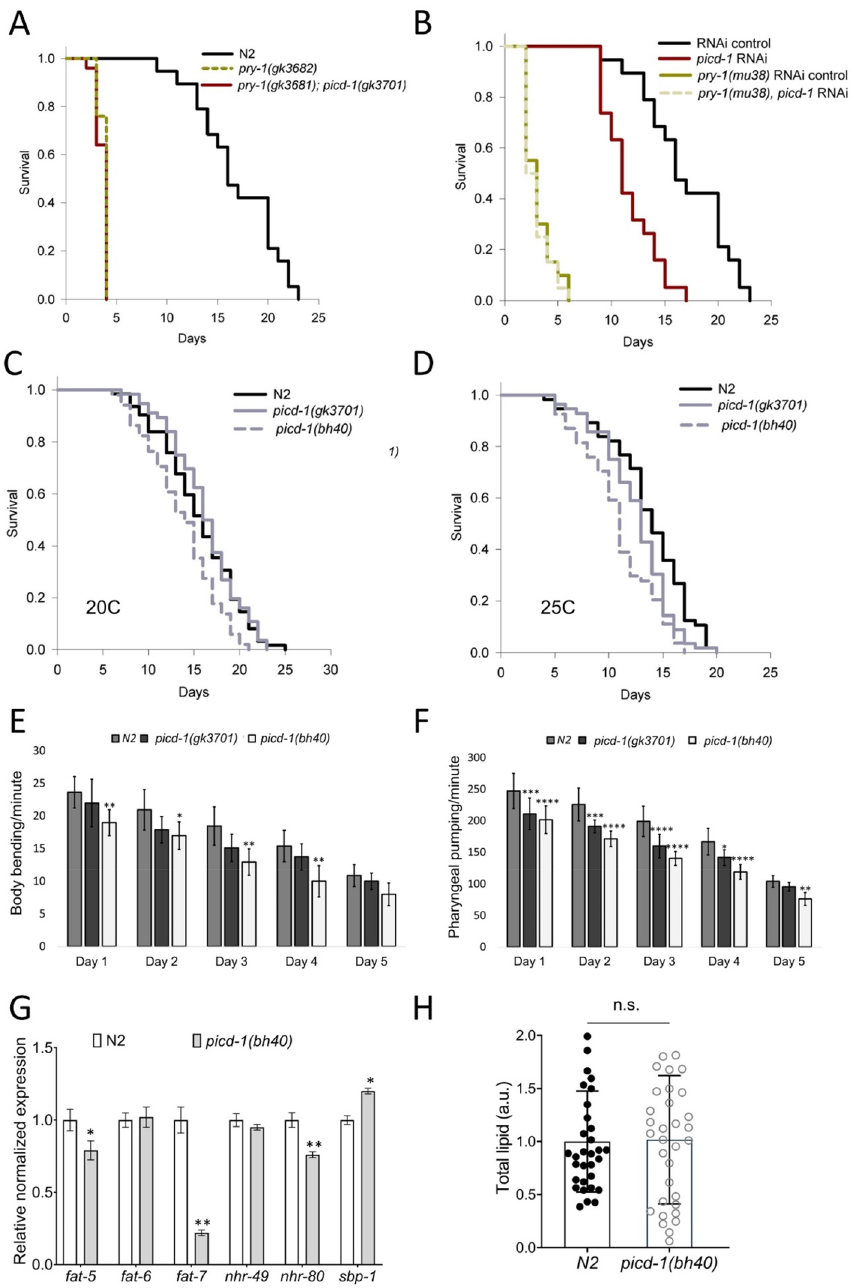
Figure 9. picd-1 mutation reduces lifespan and causes age-associated deterioration. ( A ) picd-1 mutation does not affect the lifespan of pry-1 mutants. ( B ) picd-1 RNAi reduces the lifespan of control animals but not that of pry-1 mutants. ( C,D ) Lifespan of picd-1(gk3701) and picd-1(bh40) mutants at 20 °C and 25 °C. See “Materials and methods” section and Table 2 for lifespan data and statistical analyses. ( E,F ) Bar graphs showing the rates of body bending and pharyngeal pumping of picd-1 mutants compared to wild-type over a period of 5 days. Data represent a cumulative of two replicates (n = 10 animals) and error bars represent the standard deviation. Statistical analyses were done using two-way ANOVA with Tukey’s multiple comparison test. See Table S2 for detailed statistical analyses. ( G ) Expression analysis of fat-5, fat-6, fat-7, nhr-49 , nhr-80 and sbp-1 genes in the picd-1(bh40) mutants compared to wild-type. Data represent the means of two replicates and error bars represent the standard error of means. p values were calculated using Bio-Rad software (one-way ANOVA). ( H ) Quantification of total lipid using Oil Red O in the wild-type and picd-1(bh40) animals. Data represent a cumulative of two replicates (n > 30 animals) and error bars represent the standard deviation. Statistical analysis was done using an unpaired t-test. In all cases, significant differences are indicated by stars (*): * ( p < 0.05), ** ( p < 0.01), *** ( p < 0.001), and **** ( p <